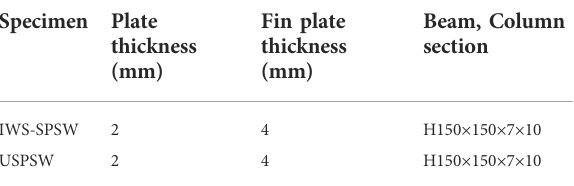
TABLE 1 Details of important parameters of the specimens.